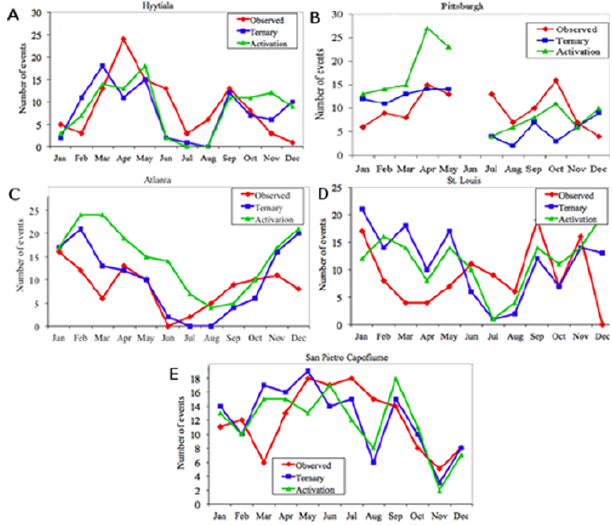
Fig. 4. New particle formation event frequency as a function of month for the five datasets and simulations. Observations are in red, ternary nucleation model (with a 10 − 5 tuning factor) is in blue, and activation nucleation is in green. Data is missing in June at PGH (Pittsburgh) due to SMPS malfunction.